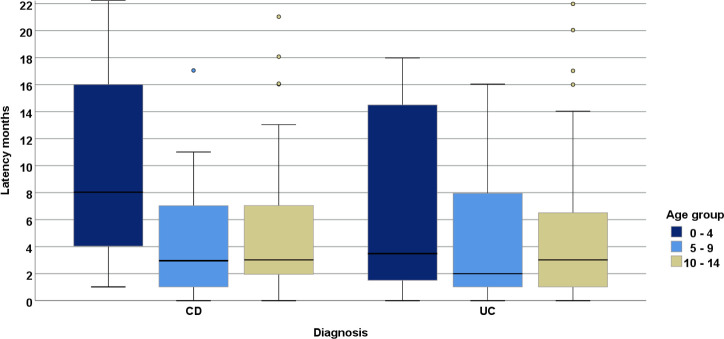
Latency months in 3 age groups using boxplots and separated by diagnosis: Crohn’s Disease (CD) and Ulcerative Colitis (UC).